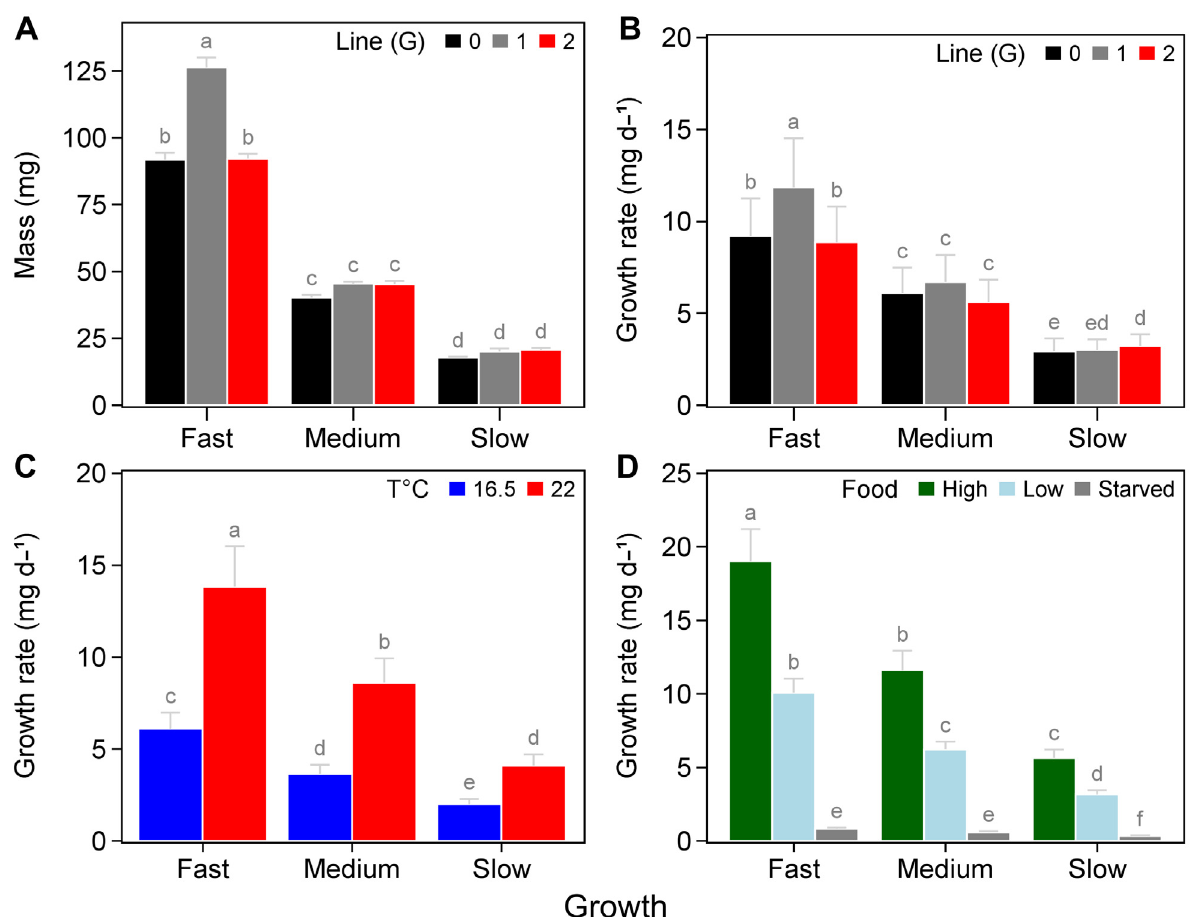
Fig. 2. Individual oyster (A) mass at the beginning of the acclimation period, (B) growth rate during the acclimation period and growth rates of oysters as a function of (C) temperature × line and (D) food × growth (D) for fast-, medium- and slow-growing oysters selected from each line (G0, G1, G2). Data are means ± SE (n = 3 tanks for each combination of food × temperature). Lowercase letters indicate significant differences. G: